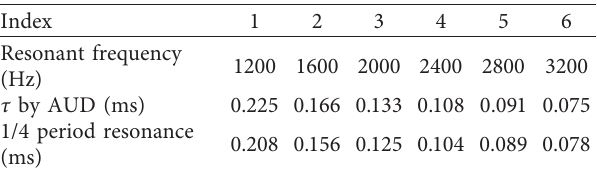
Figure 3: Mesh phase portraits of different τ . Table 1: Delay time τ of different resonant frequency fault response